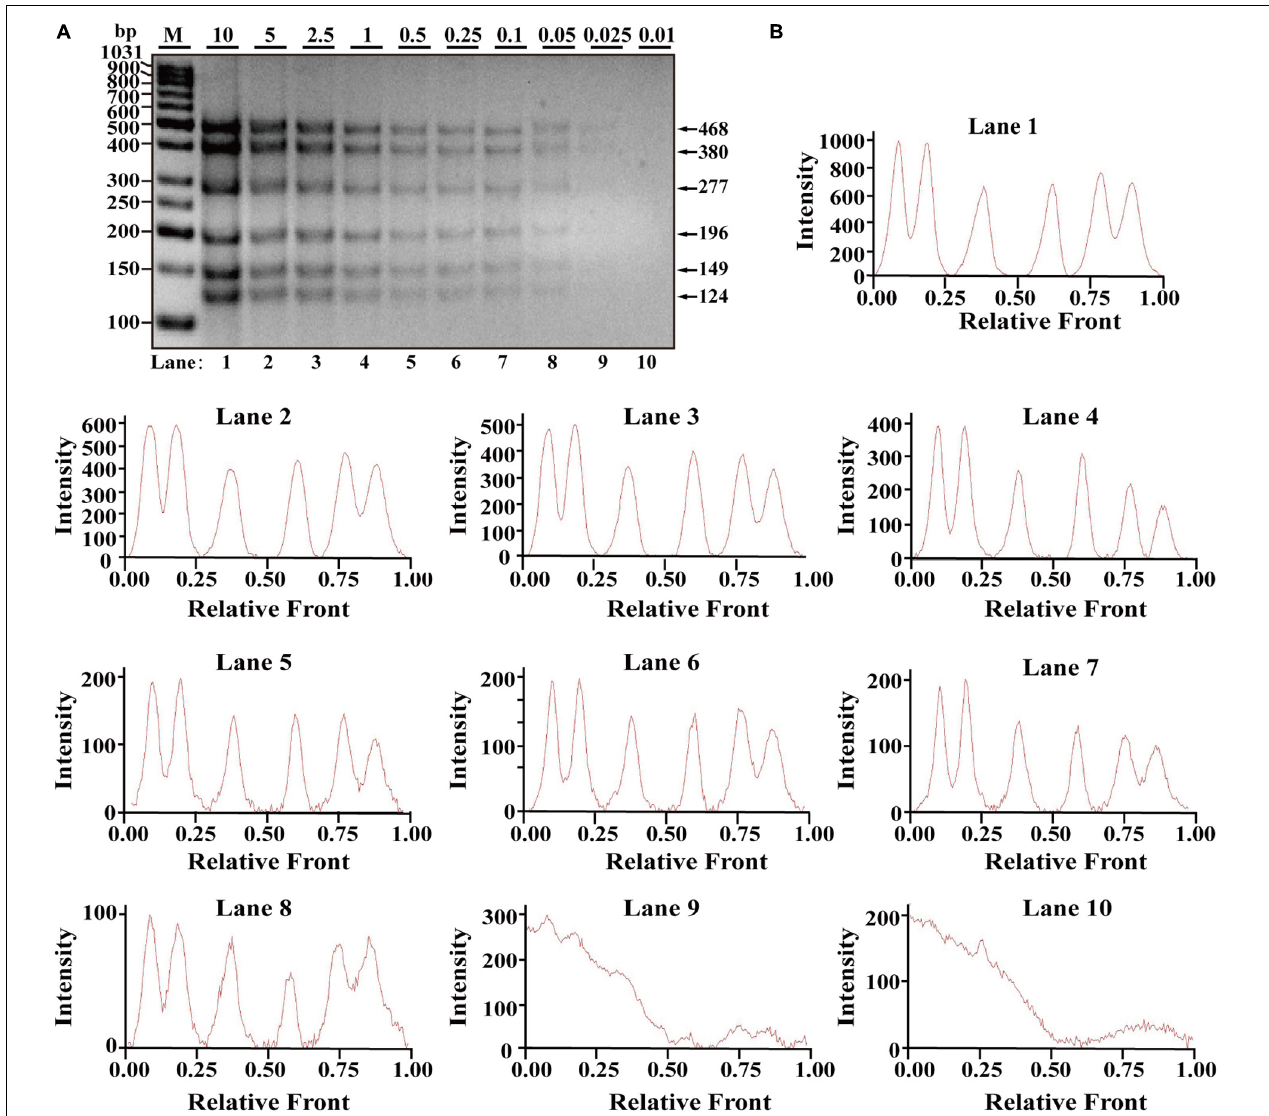
FIGURE 2 | Validation of the sensitivity of the one-tube hexaplex PCR assay. (A) Gel image of multiplex PCR fragments amplified with six primer pairs and DNA mixture of six species: turkey, dog, chicken, duck, cat, and goose under the indicated concentration in a single PCR reaction. (B) Using Image Lab Software, electropherograms were drawn based on bands. Lanes 1–10 are represented labels of 10, 5, 2.5, 1, 0.5, 0.25, 0.1, 0.05, 0.025, and 0.01 in (A) . The value of number in the horizontal line means the relative position of peaks distant from the top of agarose gel. The value of number at the vertical line means the fluorescent intensity of PCR fragments using 4S GelRed Nucleic Acid Stain. Lane M is ladder